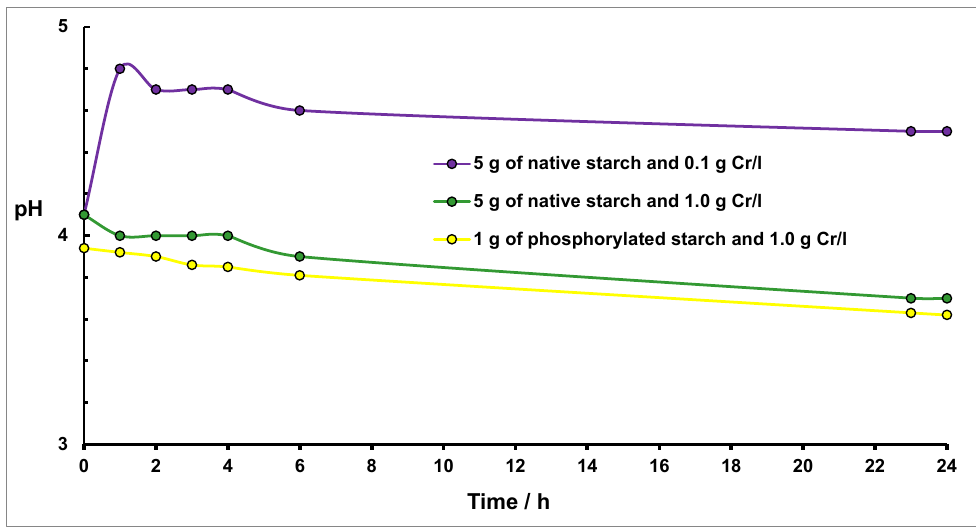
Figure 7. Changes of pH for the native and phosphorylated starch suspensions in the Cr(NO 3 ) 3 solutions as a function of time. Conditions: 5 g of native starch in 22.5 cm 3 of 0.1 g Cr/L (purple line), 1.0 g Cr/L (green line) Cr(NO 3 ) 3 solutions, and 1 g of phosphorylated starch in 22.5 cm 3 of 1.0 g Cr/L Cr(NO 3 ) 3 solution (yellow line), room temperature.